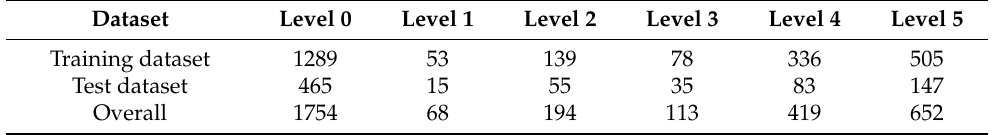
Table 1. Caries occurrences in proximal surfaces in the reference dataset.